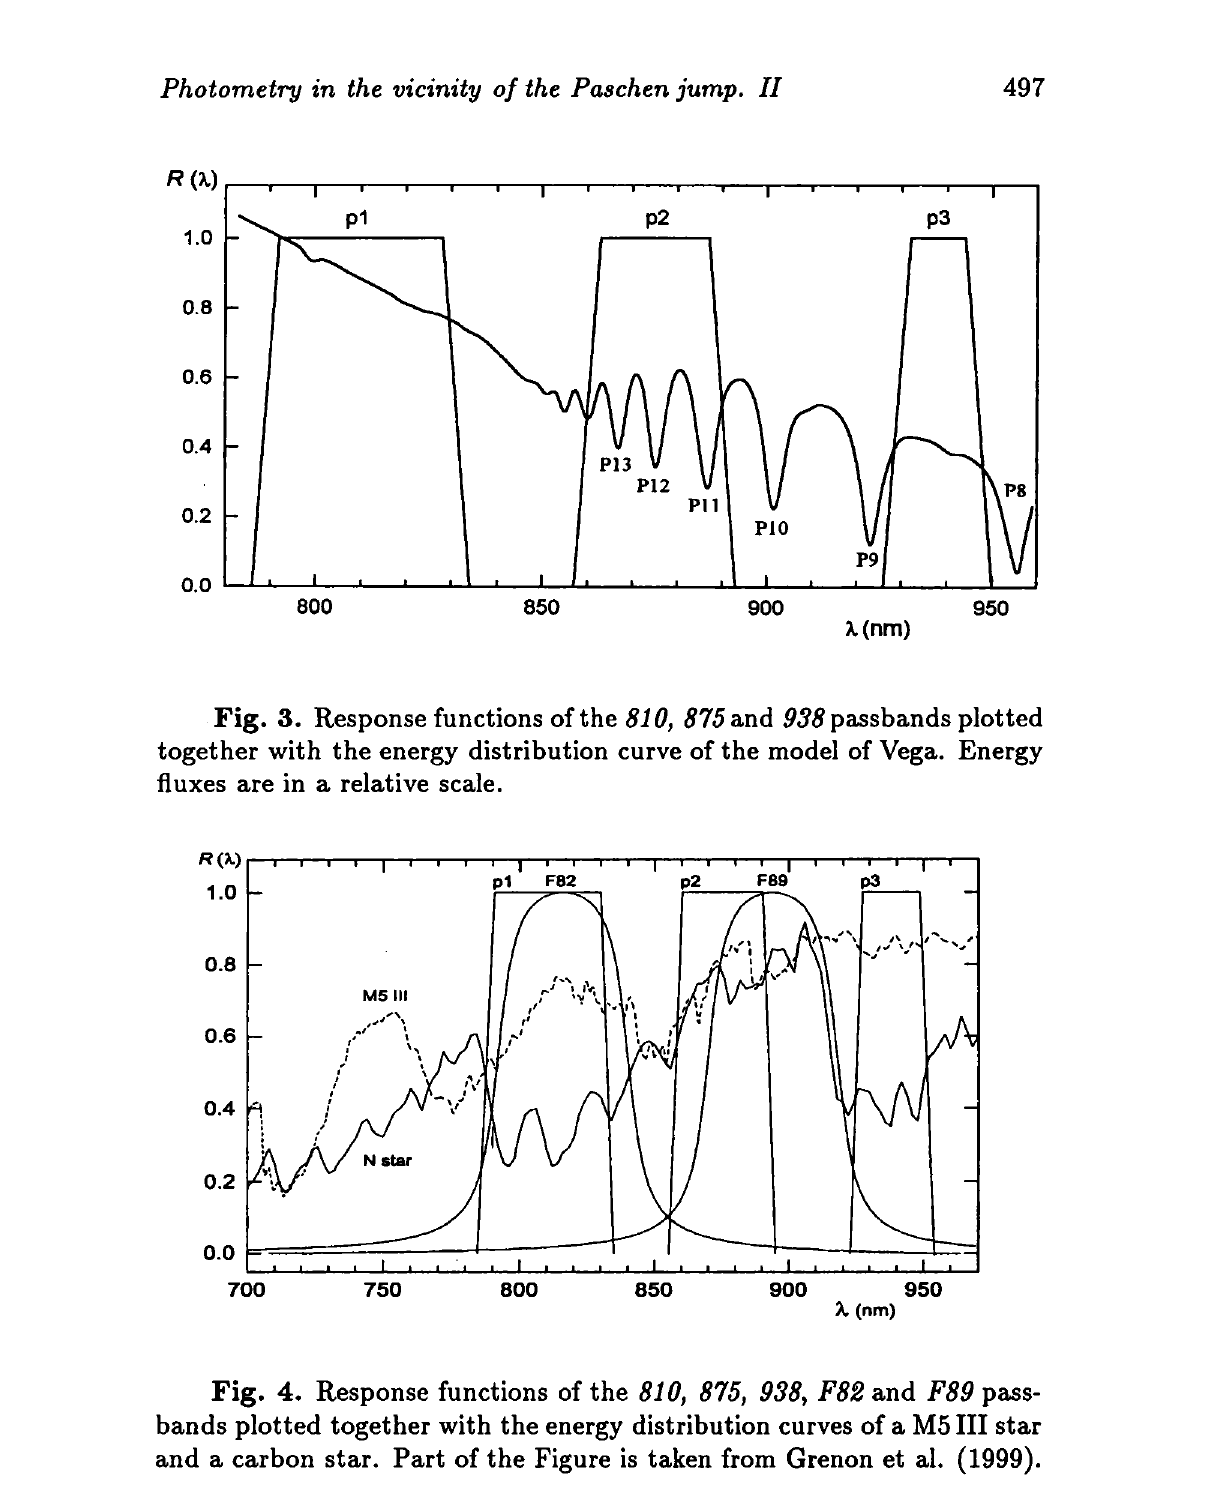
Fig. 4. Response functions of the 810, 875, 938, F82 and F89 pass- bands plotted together with the energy distribution curves of a M5 III star and a carbon star. Part of the Figure is taken from Grenon et al.